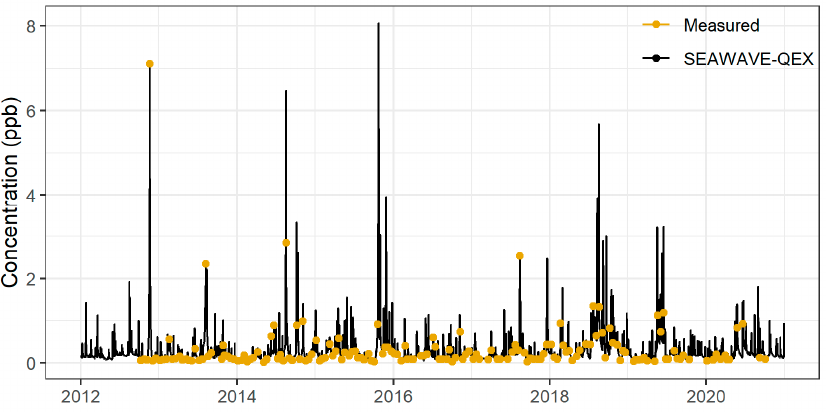
Figure 2. SEAWAVE-QEX exposure profile for hydroxychlorothalonil at USGS-08057200.